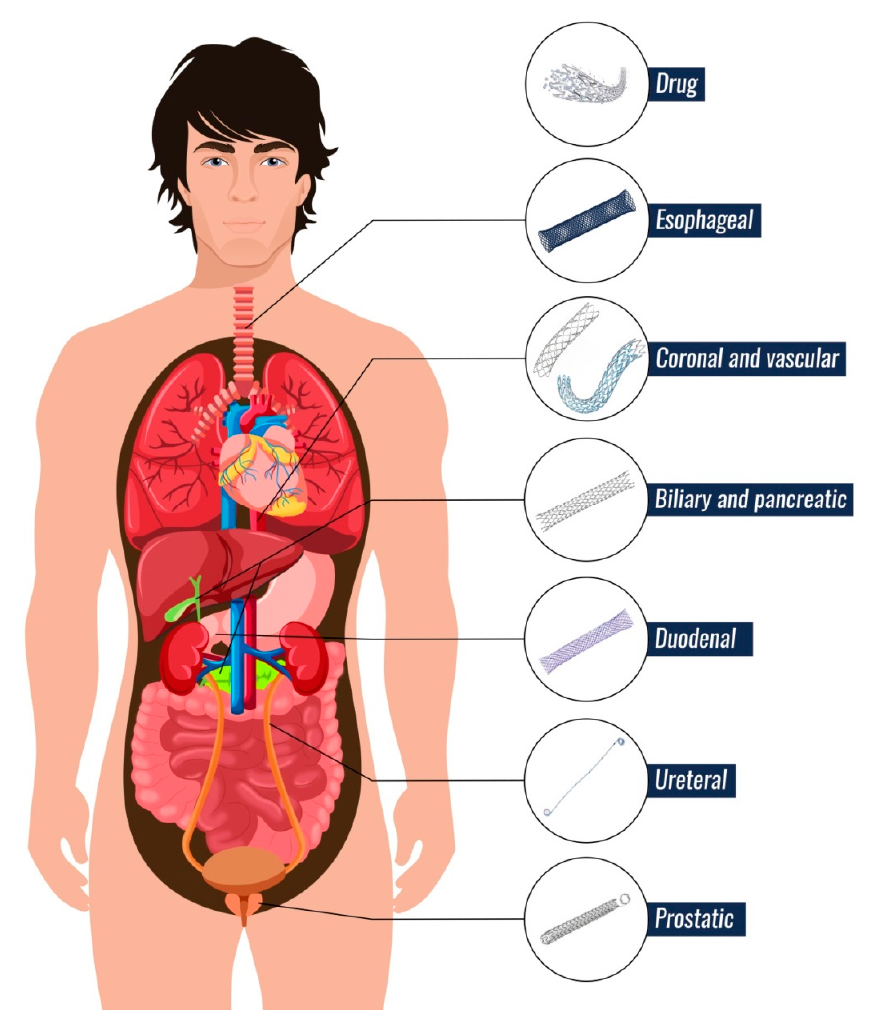
Figure 2. Nine main types of stents.